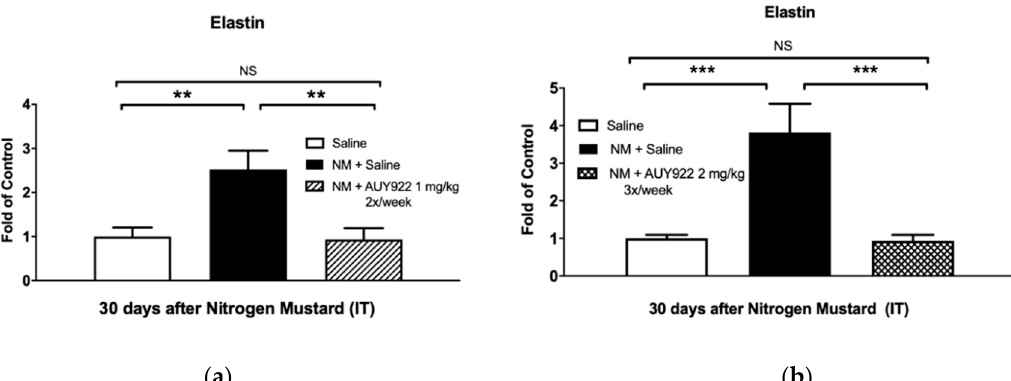
Figure 5. The HSP90 inhibitor, AUY-922, blocks the NM-induced elastin production. Total elastin mRNA levels in lung tissue homogenates was determined by real time qPCR, as described in Methods. Mice received 0.625 mg/kg of NM or saline (2 μ L/g body weight, intratracheally) on day 0. They then received AUY-922 (1 mg/kg, 2×/week ( a ) or 2 mg/kg, 3×/week ( b ) intraperitoneally) for 30 days, starting 24 h after NM. Means ± SEM; n = 4 mice per group; **: p < 0.01, ***: p < 0.001, NS: not significant, with ANOVA and Tukey’s.